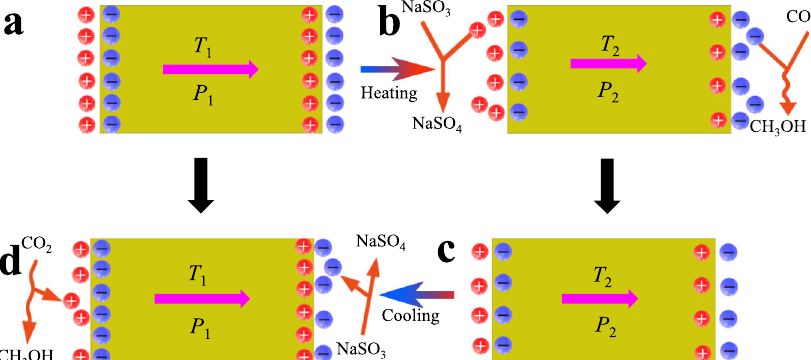
Fig. 5 The mechanism of pyro-catalytic CO 2 reduction induced by pyroelectric Bi 2 WO 6 nanoplate. a The temperature of catalyst remains constant, its spontaneous polarization in equilibrium with the bound charges. b The rapid rise in temperature broke the balance, and thus induce CO 2 reduction reaction. c A new balance is established after the CO 2 reduction reaction. d When the temperature drops, the opposite charges transfer, leading to a new CO 2 reduction